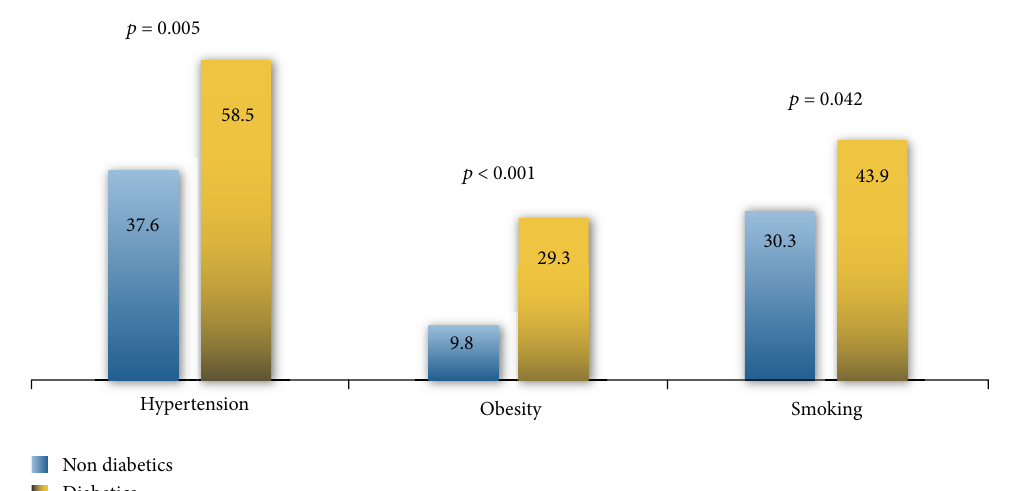
Figure 3: Comparison of diabetic and nondiabetic patients according to hypertension, obesity, and smoking.